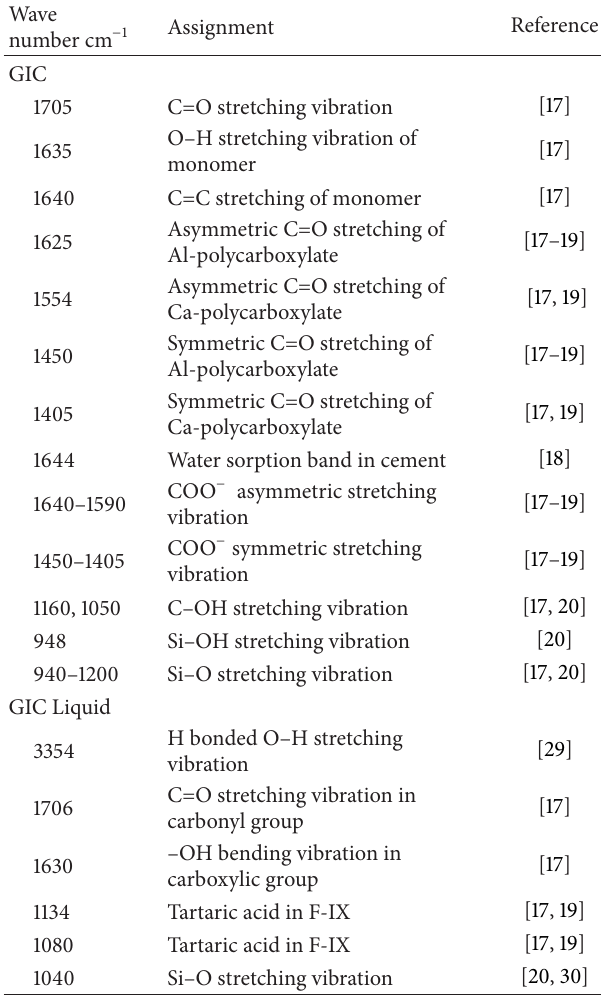
Table 3: Description of FTIR peaks assignment present in the spectra of Fuji-IX liquid and Fuji-IX cements shown in Figures 2 and